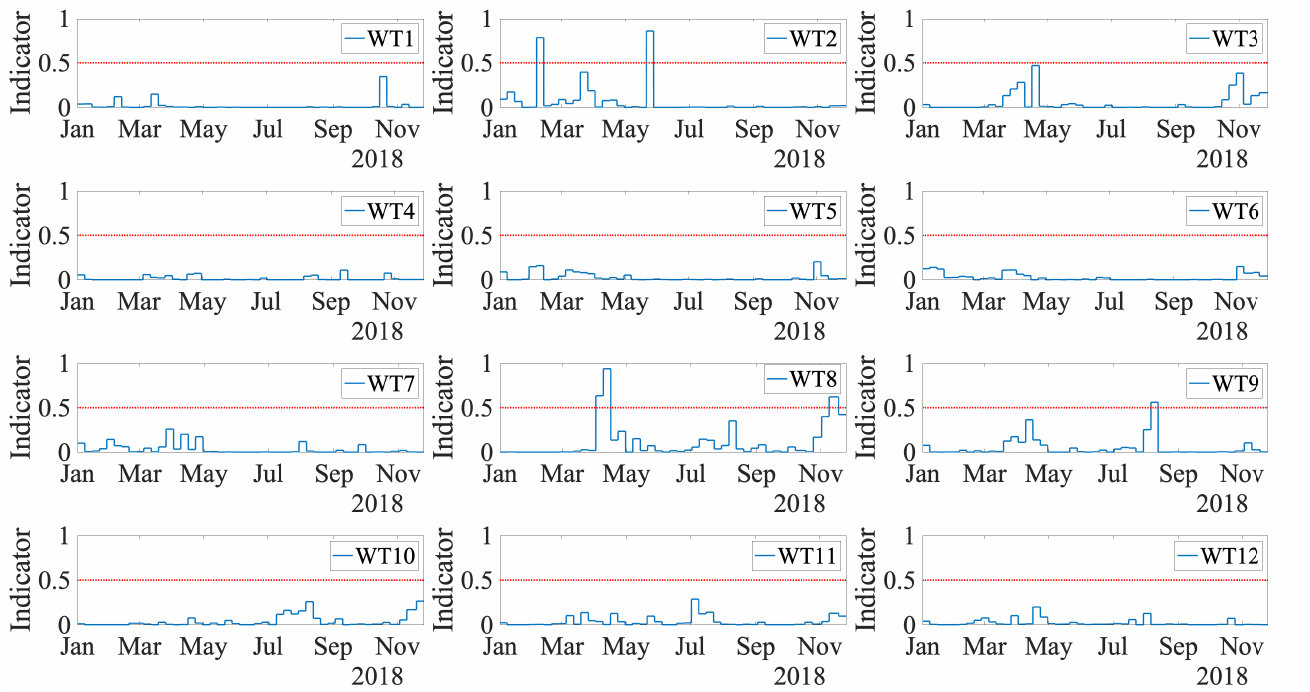
Figure 17. ANN indicator values (blue line) for test data, and threshold (red